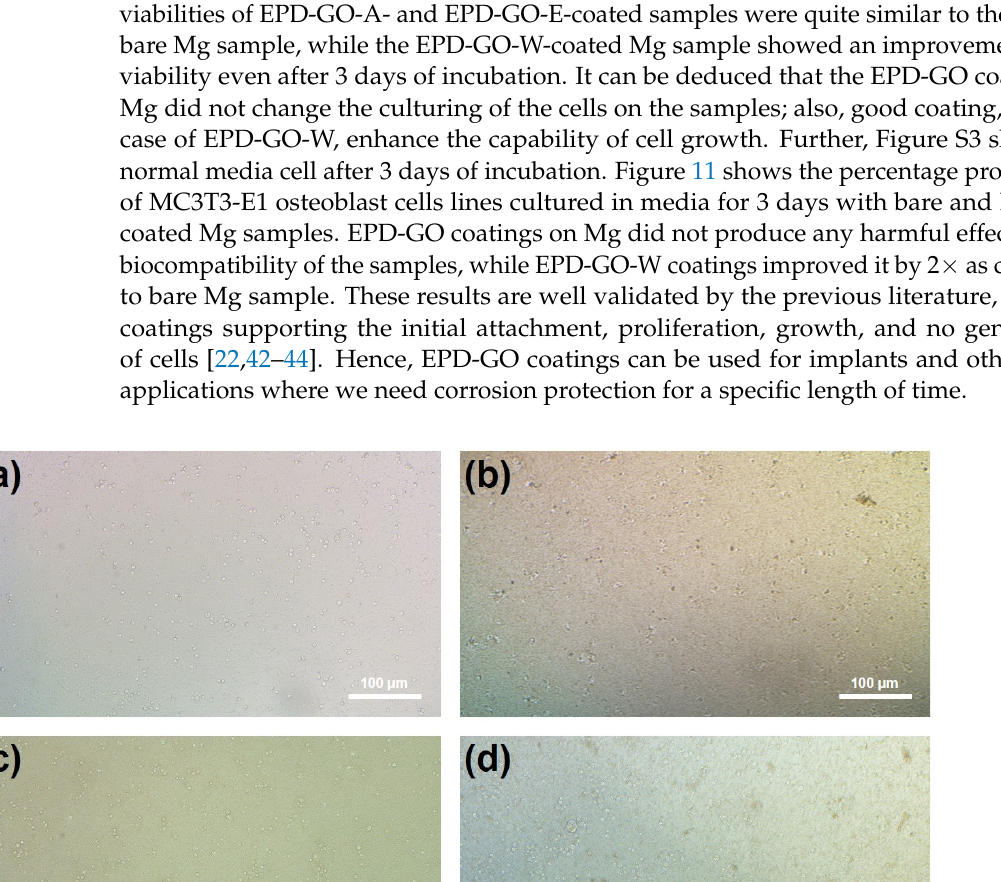
Figure 11. Percentage proliferation of MC3T3-E1 osteoblast cells lines cultured in media for 3 days with bare and EPD-GO-coated Mg samples. 4. Conclusions GO was effectively developed by improved Hummers’ method, having a thickness of ~1 nm as defined by AFM analysis. The EPD technique was used to deposit GO coatings on Mg alloy using different ultrasonicated GO suspensions of various solvents (water, ethanol and acetone). XRD of the EPD-GO-coated Mg samples confirmed the successful